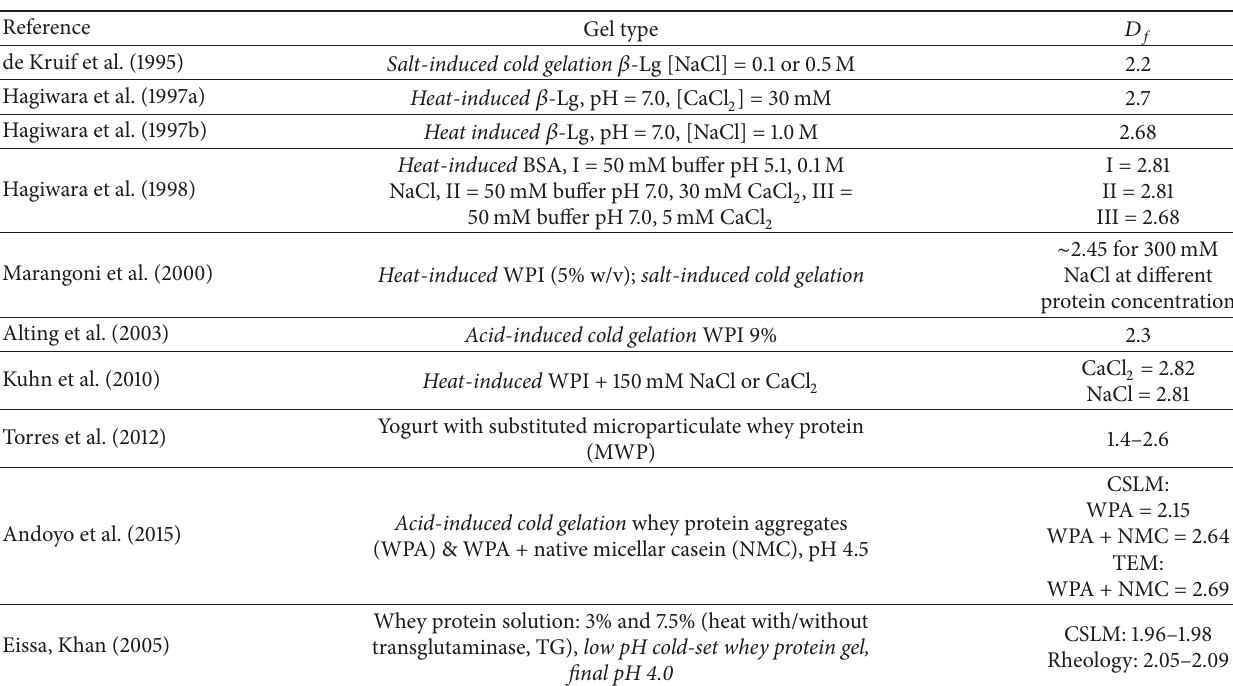
Table 2: Fractal dimension ( 𝐷 𝑓 ) values of different types of gels, measured by using microscopic